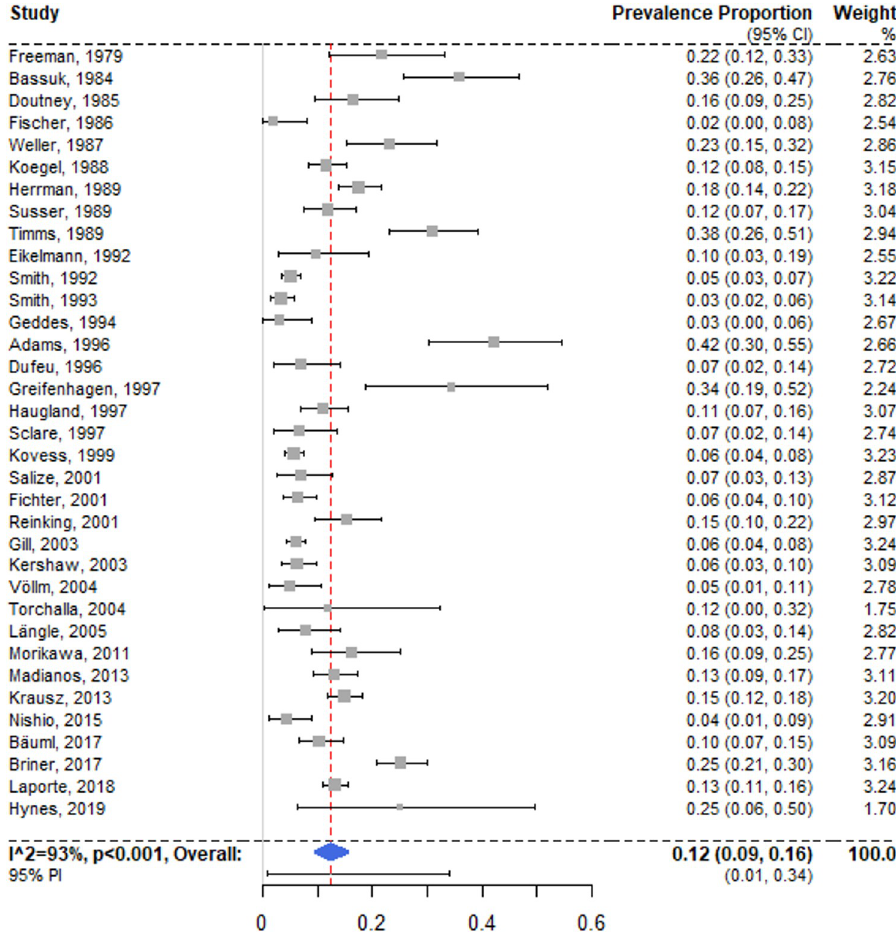
Fig 3. Forest plot of prevalence estimates of schizophrenia spectrum disorders. AU : Basedonthereferenceslist ; IbelievethefollowingareerrorsinFig 3 : ð 1 Þ Newton ; 1994 shouldbeGeddes ; 1994 ½ 67 �ð 2 Þ Gill ; 1996 shouldbeGill ; 2003 ½ 66 �ð 3 Þ Kershaw ; 2000 shouldbeKershaw ; 2003 ½ 61 �ð 4 Þ LaPorteshouldbeLaporte ½ 29 �ð 5 Þ Hynes ; 2018 shouldbeHynes ; 2019 ½ 62 � PleasefixtheseerrorsinFig 3 : Asecond (cid:0) bestsolutionwouldbetoequatethesemisidentifiedrefswiththeircorrectreferencenumbersinthefigurelegend : Analytic weights are from random effects meta-analysis. Grey boxes represent study estimates; their size is proportional to the respective analytical weight. Lines through the boxes represent the 95% CIs around the study estimates. The blue diamond represents the mean estimate and its 95% CI. The vertical red dashed line indicates the mean estimate. CI, confidence interval; PI, prediction interval; RE, random